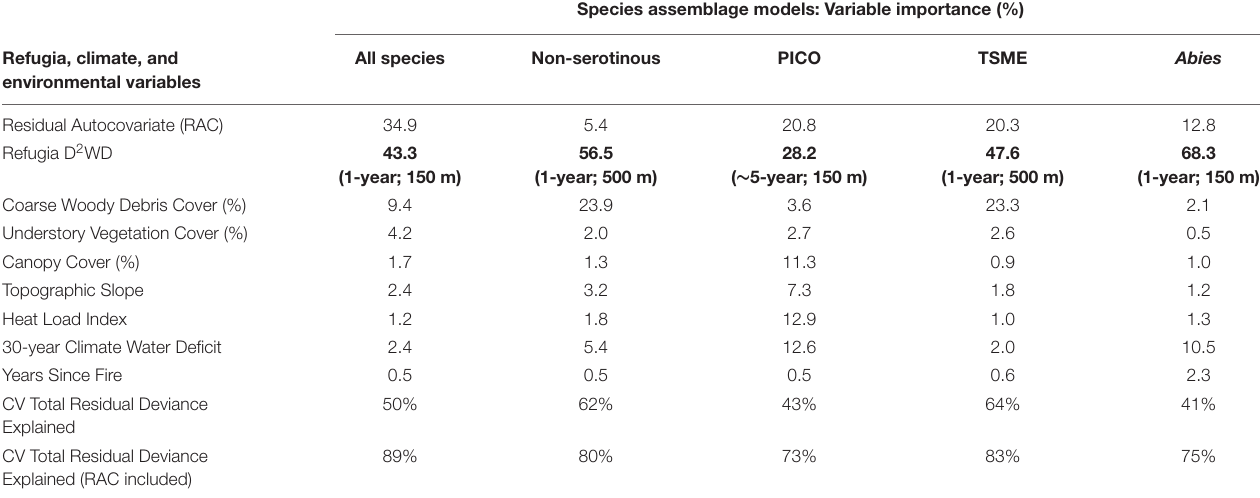
FIGURE 3 | The strongest pair-wise interactions across species assemblage BRT models between three spatial or structural estimates of fire refugia: distance to refugia and (1) refugia patch mean live tree height (A–E) , (2) refugia D2WD (F–J) . Along the brown-to-blue-green color spectrum, brown shading indicates relatively reduced and blue-green shading relatively increased post-fire establishment due to pair-wise variable interactions. TABLE 3 | Variable Importance and model performance from the BRT models evaluating relationships between observed conifer juvenile establishment and the best performing refugia-related, climate, and environmental predictors, by species assemblage. Species assemblage models: Variable importance